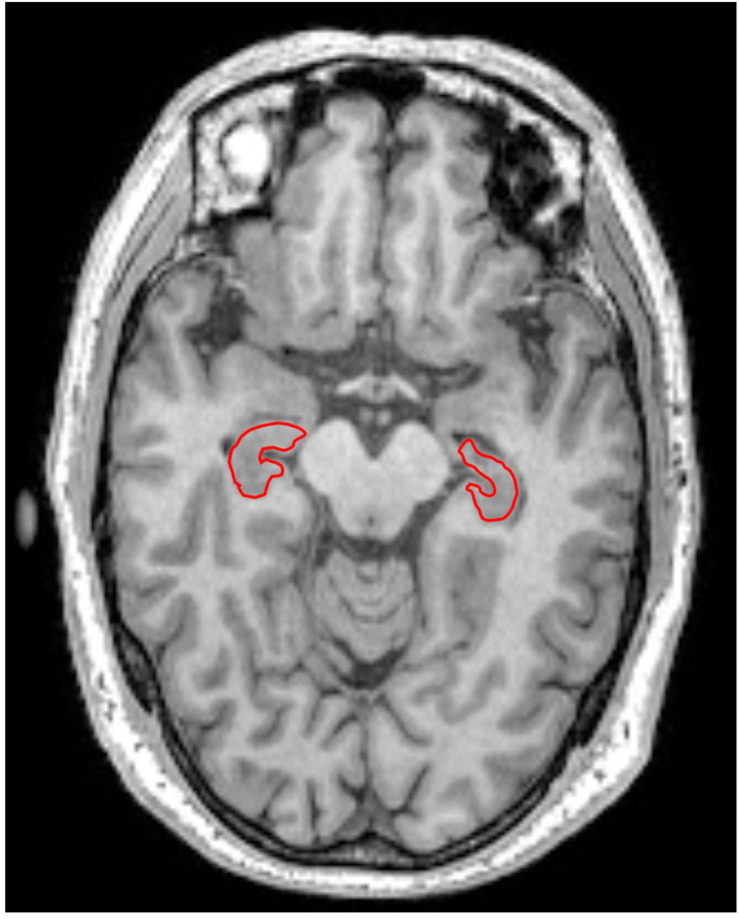
Left and right hippocampus were selected as regions of interest (ROIs) in this study. ROIs were encircled in red line in T1 weighted imaging.